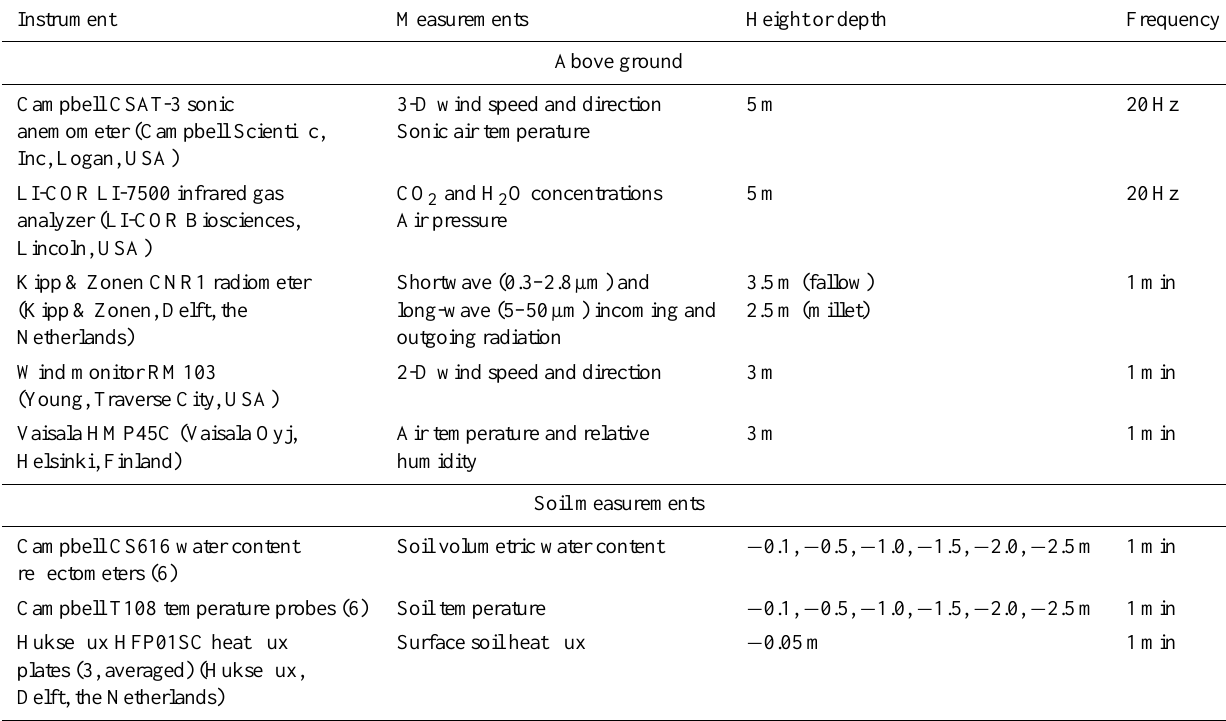
Table 1. Description of permanent GAI-recording stations in the Wankama fallow and millet plots.